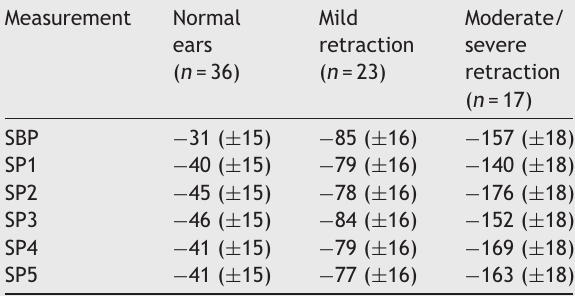
Estimated means obtained with a linear mixed model for the sniff test in the three study groups, at the first time point of assessment.